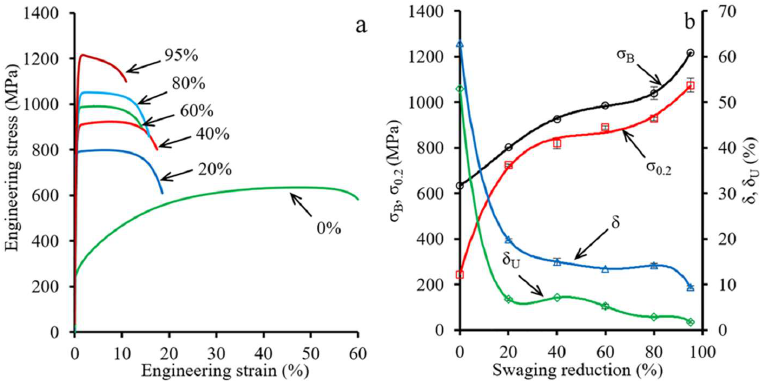
Figure 7. ( a ) Stress-strain curves and ( b ) tensile properties-strain plots of the program